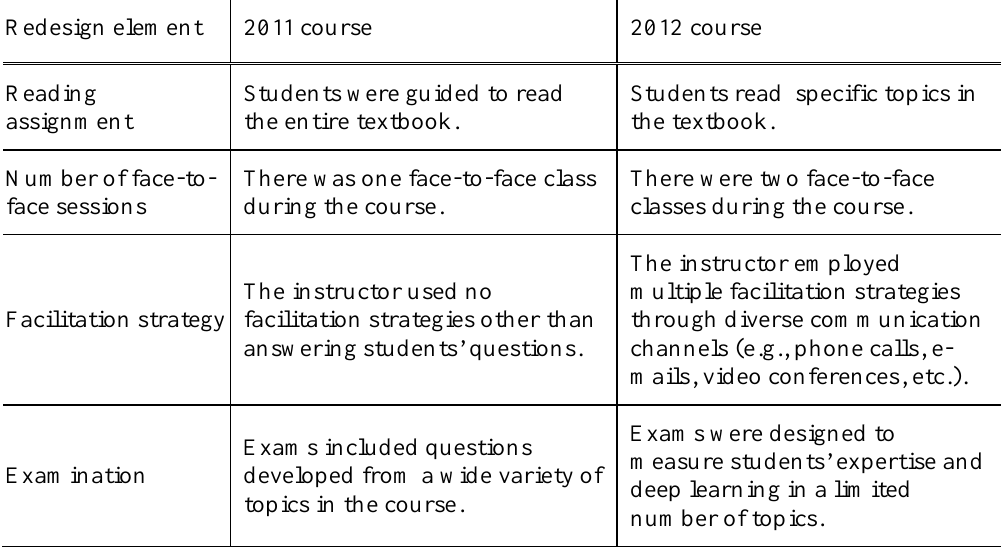
Changes Conducted Between 2011 and 2012 in the Quality Control Course Redesign